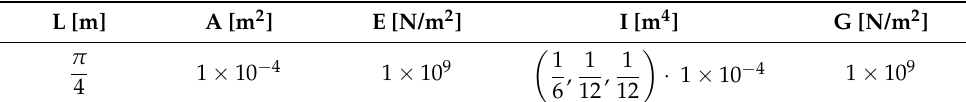
Table 1. Geometrical and material properties of the rod used for the static deformation test.